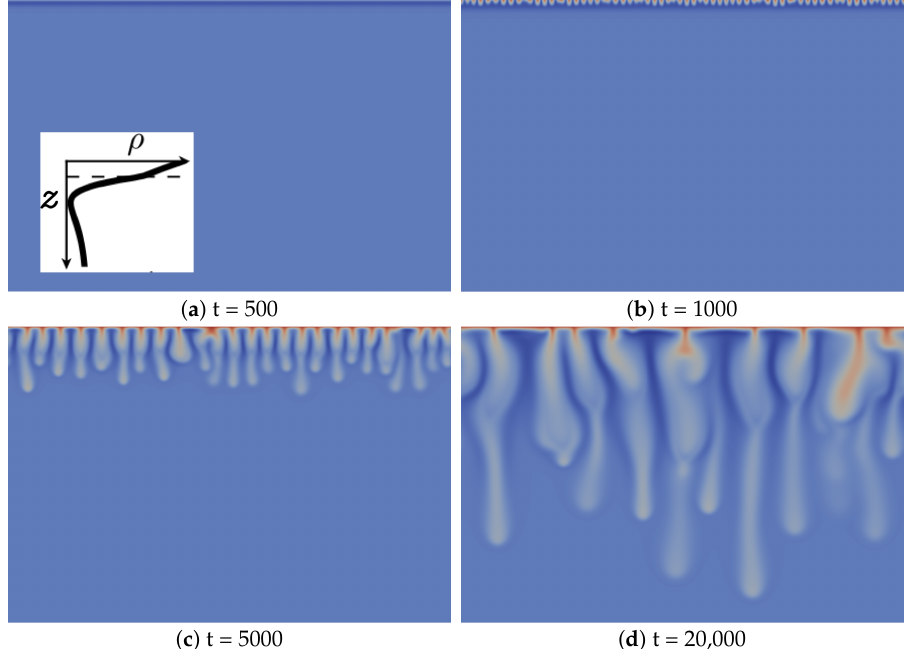
Figure 2. Density fields at different times ( a – d ) illustrating the fingering dynamics in Zone III ( δ B = 1, δ C = 0.5 and R B = 1). A typical reaction-diffusion density profile is enclosed in Figure 2a. The density scale varies between 0.75 (dark blue) and two